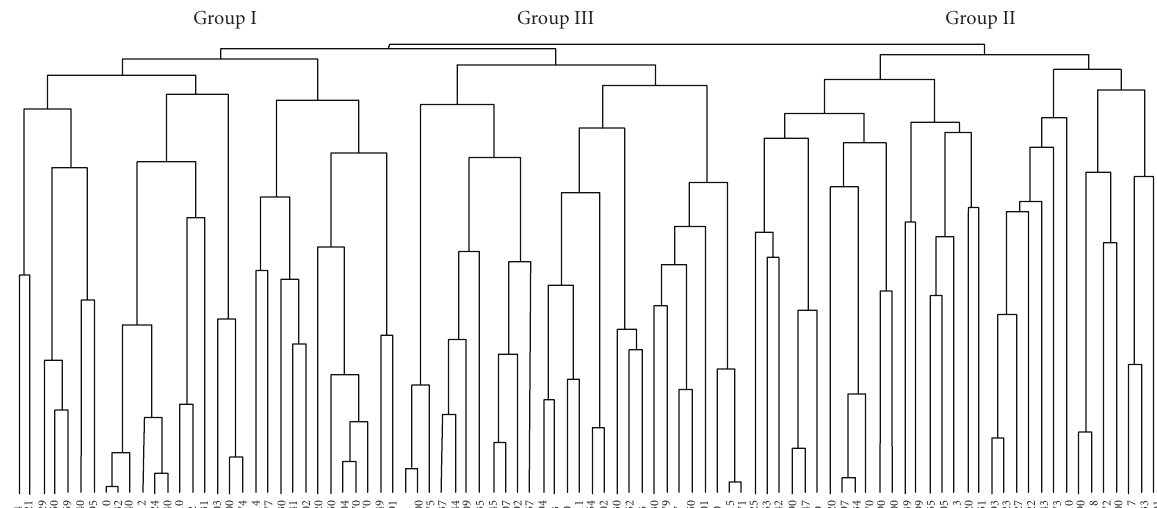
Figure 1: Dendrogram of hierarchical